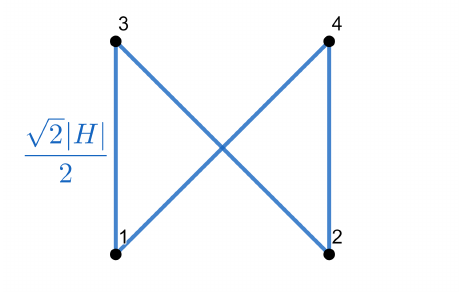
Figure 3. Example 3.